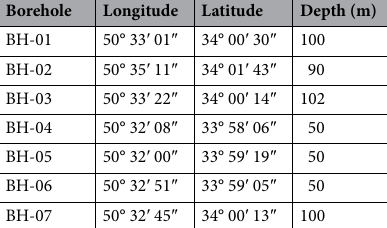
Table 4. General properties of drilled wellbores in Mahallat